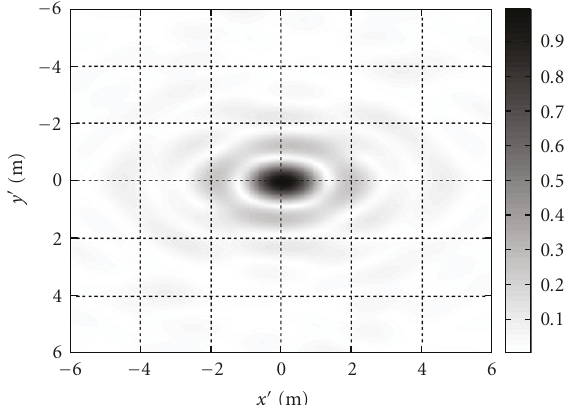
Figure 9: Reference image I ref of an isotropic point. SAL = 48km and N = 103 transmitters.